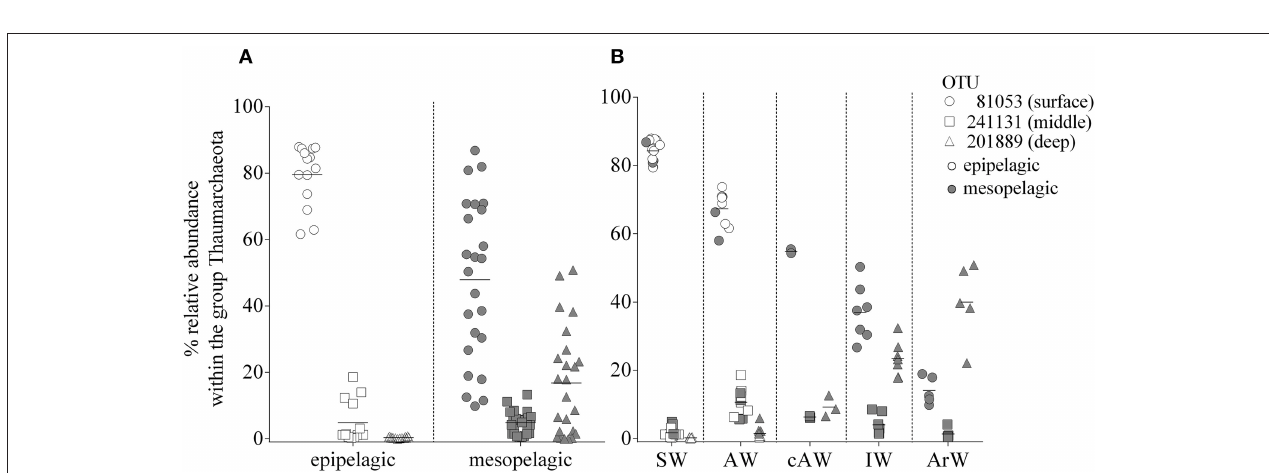
FIGURE 4 | (A) Relative abundance of the three most abundant Thaumarchaeota OTUs. Samples were divided according to their sampling origin in epipelagic (open symbols; 0–200m; n = 16) and mesopelagic (filled symbols; 200–1,000m; n = 22) zones. (B) Same data as in (A) , grouped according to assigned water masses based on sample similarities illustrated in Figure 3 . ArW, Arctic Water; SW, Surface Water; AW, Atlantic Water; cAW, cold Atlantic Water; IW, Intermediate